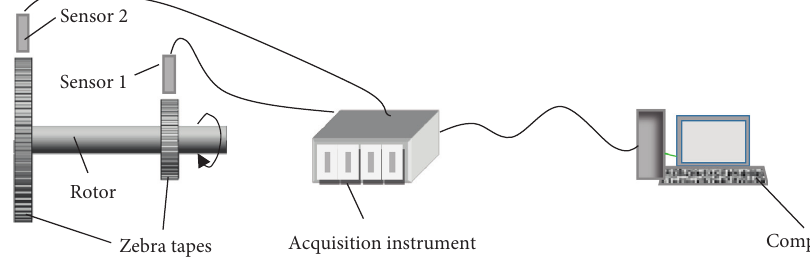
Figure 1: Schematic diagram of torsion measuring devices on zebra-tape